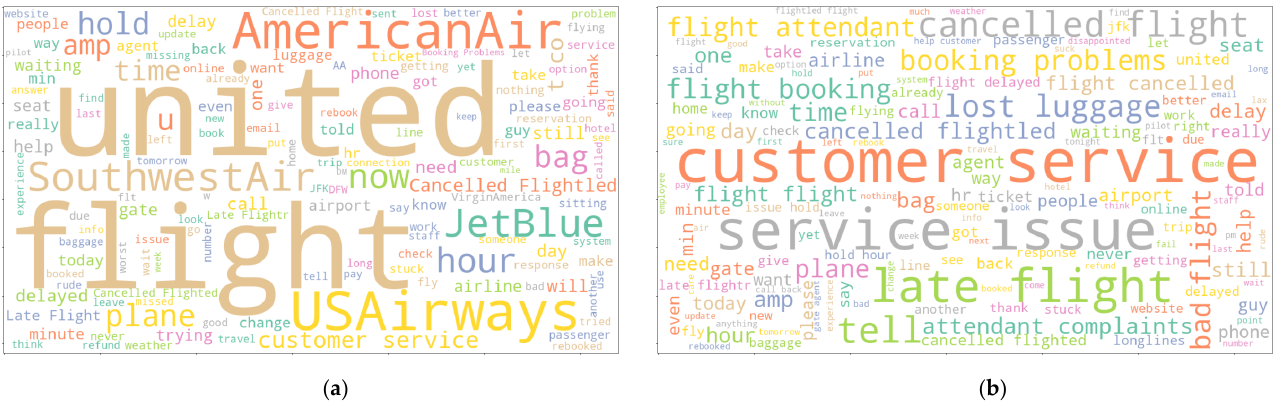
Figure 9. ( a ) Word Cloud of negative tweets—before preprocessing and ( b ) Word Cloud of negative tweets—after preprocessing.